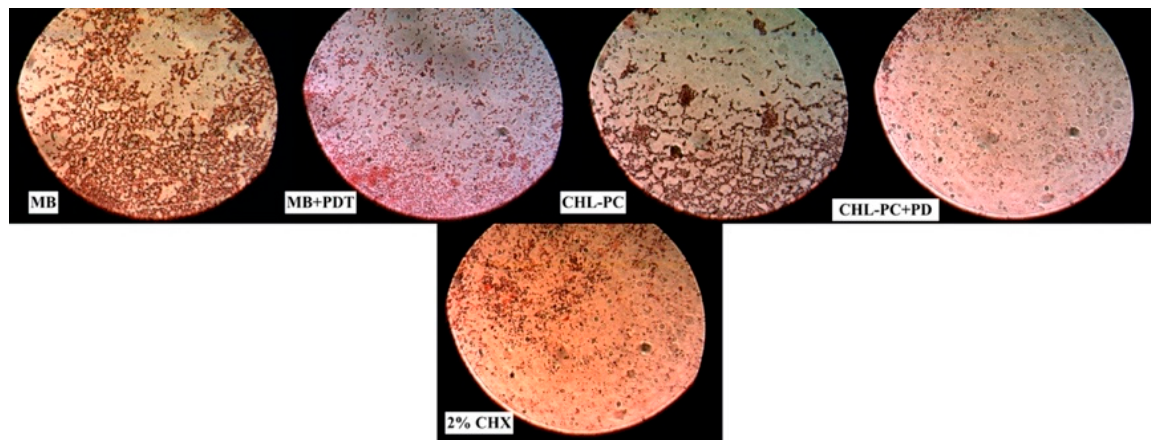
Figure 5. Characterization of bacterial colonies after MB, MB + PDT, CHL–PC, CHL–PC + PDT, and 2% CHX experimental treatments using an optical microscope (OPTIKA, B-600Tiph, Italy, 100×/1.25× oil PH, PLAN).